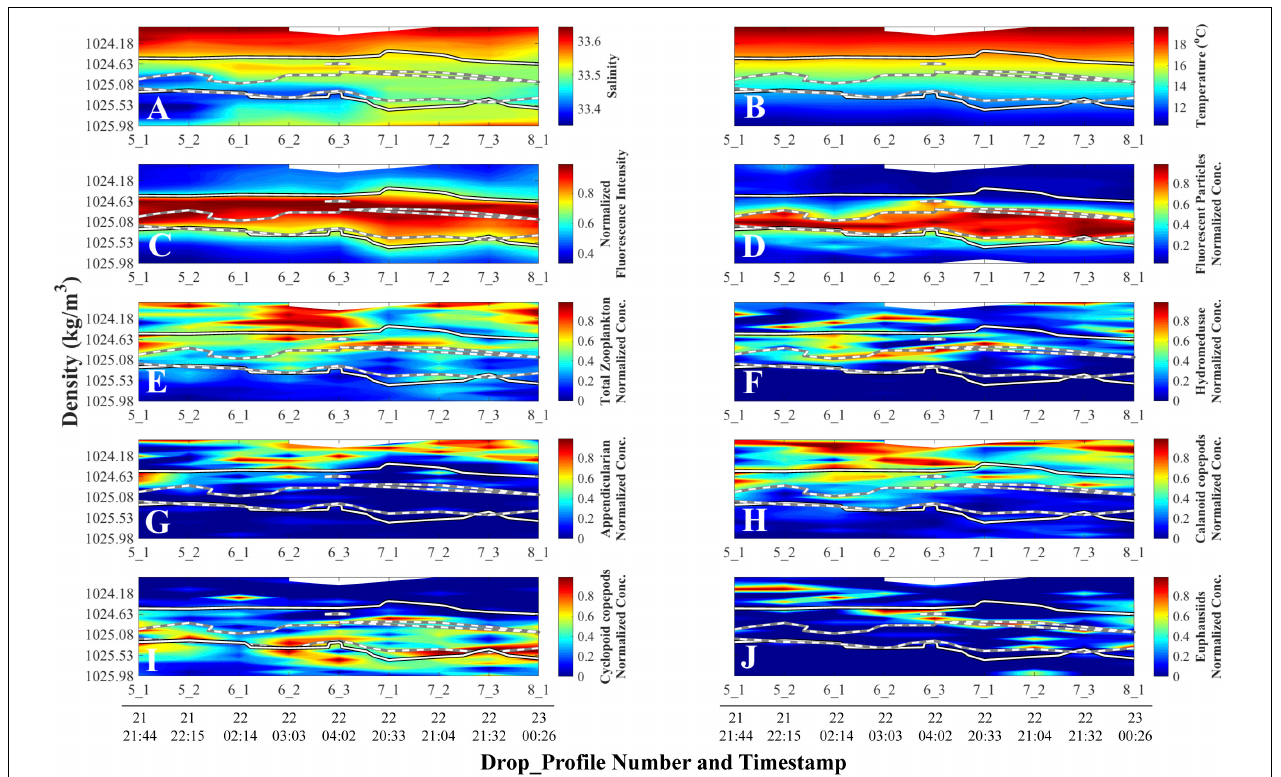
FIGURE 6 | Density-time distributions of physical and normalized biological data. Day and time (all in August 2011, Pacific Standard Time) are at the bottom of each column and apply to all the panels above the line of timestamps. Full details on each Drop_Profile can be found in Table 1 . (A) Salinity; (B) Temperature ( ◦ C); (C) Fluorescence Intensity (SBE 25 fluorometer); (D) Planar Laser Imaging Fluorometer (PLIF) fluorescent particle normalized concentration. Panels (E) through (F) represent O-Cam zooplankton normalized concentrations: (E) Total zooplankton; (F) Hydromedusae; (G) Appendicularians; (H) Calanoid copepods; (I) Cyclopoid copepods; and (J) Euphausiids. Solid lines superimposed on panels represent the 70% threshold normalized Fluorescence Intensity from panel (C) , and white-on-black lines superimposed on panels represent the 70% threshold fluorescent particle normalized concentration contour from panel (D)